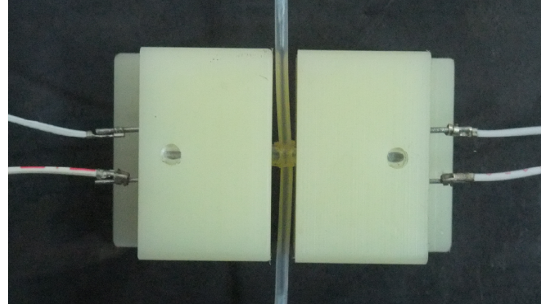
Figure 2. The prototype of the ultrasonic probe (top